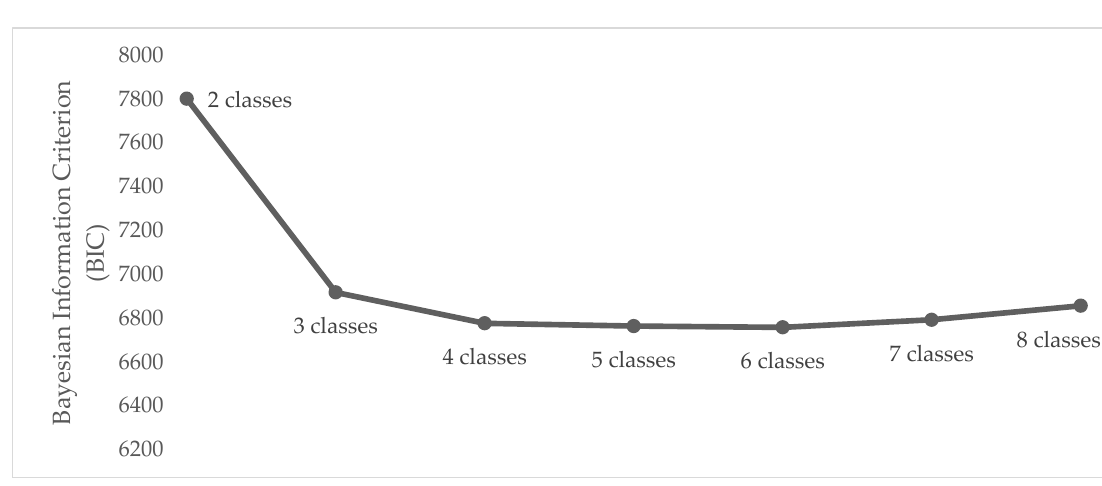
Figure 1. Bayesian Information Criterion (BIC) for latent class models.